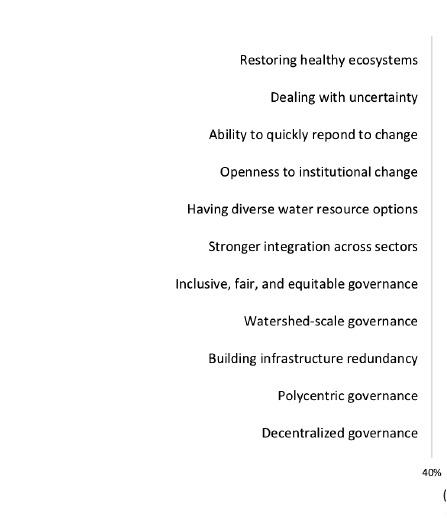
Fig. 2 . General water resilience strategies. Survey respondents were asked to rate, on a scale of 1 to 5, each of the strategies in terms of how important they are for achieving general (or overall) resilience in water governance. While the strategies were randomly ordered on the survey, they are shown here from the highest rated at the top to the lowest rated at the